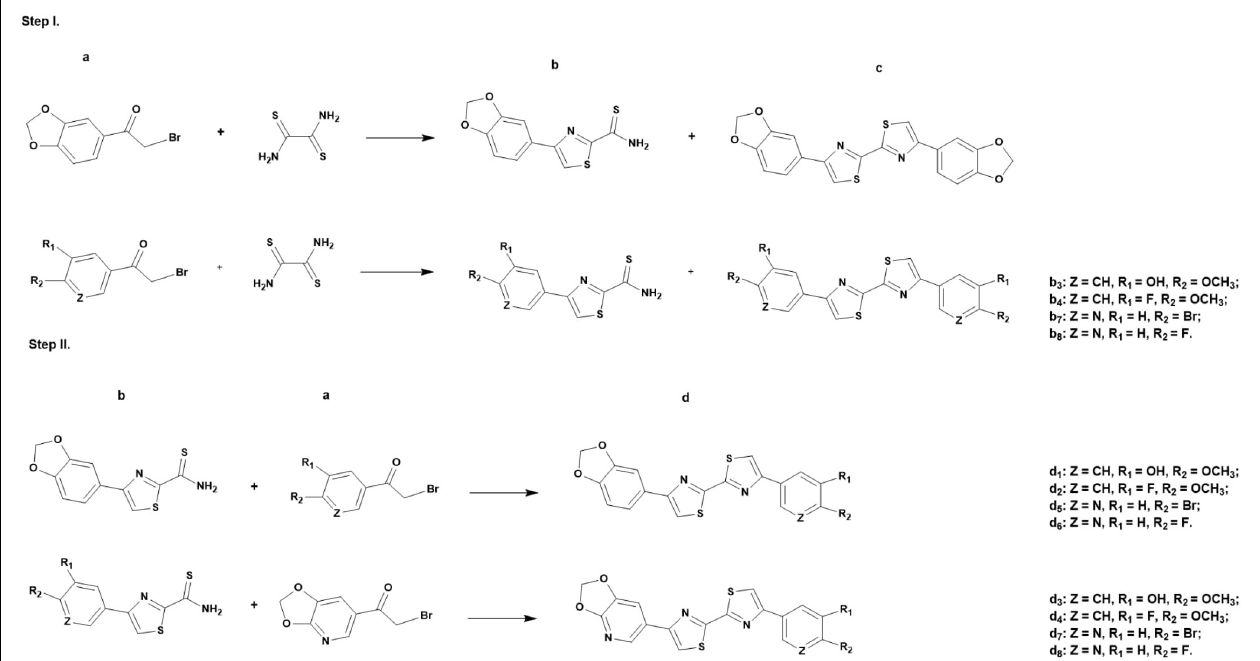
FIGURE 2 | General synthesis of the DABTAs (d 1 -d 8 ) in dimethylformamide, where a = aromatic/a heteroaromatic α -bromoketone, b = 4-arylthiazole-2- carbothioamide, c = symmetric side product, and d = asymmetric product.